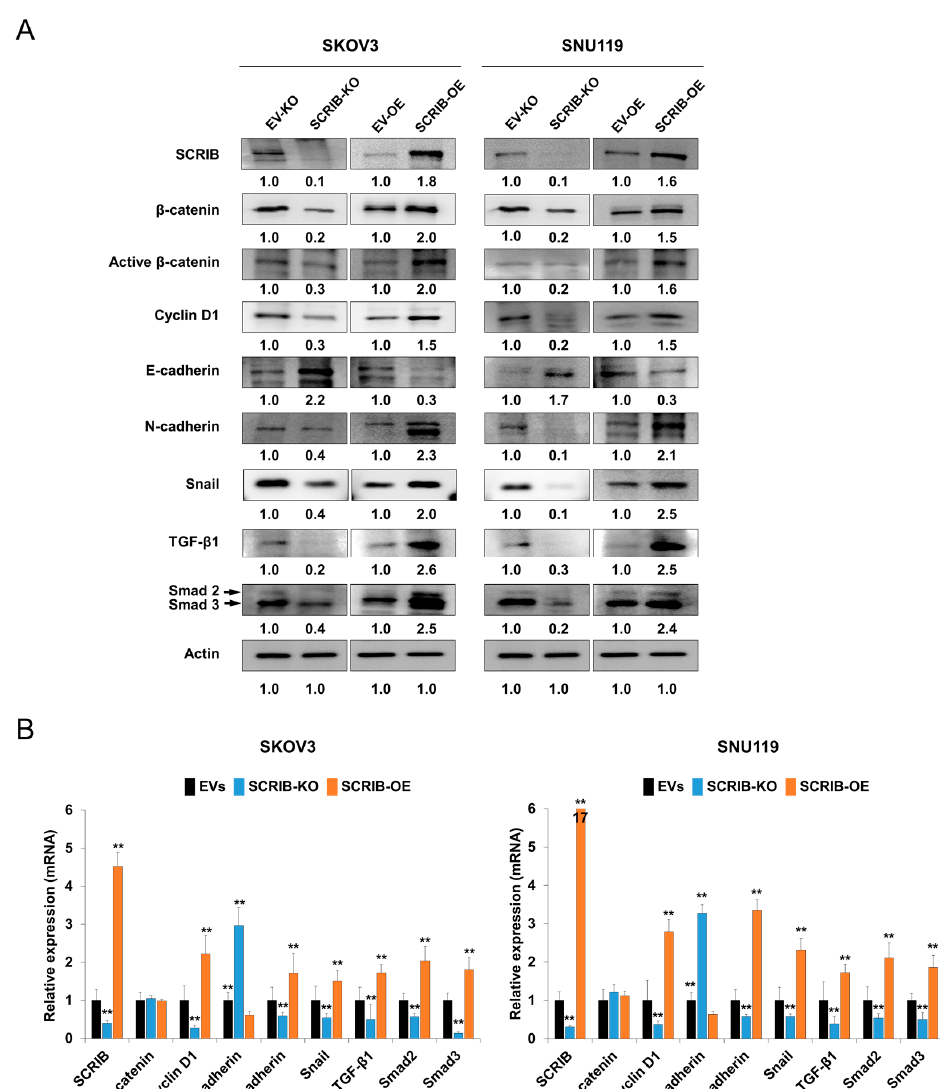
Figure 8. Western blot and quantitative reverse-transcription polymerase chain reaction after knockout or overexpression of SCRIB in ovarian carcinoma cells. ( A ) Western blot was performed for SCRIB, β -catenin, active β -catenin, cyclin D1, E-cadherin, N-cadherin, snail, TGF- β 1, smad2/3, and actin after knockout or overexpression of SCRIB in SKOV3 and SNU119 ovarian carcinoma cells. The western bands were quantified using ImageJ software and the values are indicated below the bands. ( B ) Quantitative reverse-transcription polymerase chain reaction was performed for SCRIB, β -catenin, cyclin D1, E-cadherin, N-cadherin, snail, TGF- β 1, smad2, and smad3 after knockout or overexpression of SCRIB in SKOV3 and SNU119 ovarian carcinoma cells. EVs; the cells transfected with both empty vector for knockout and empty vector for overexpression of SCRIB . ** p < 0.001.